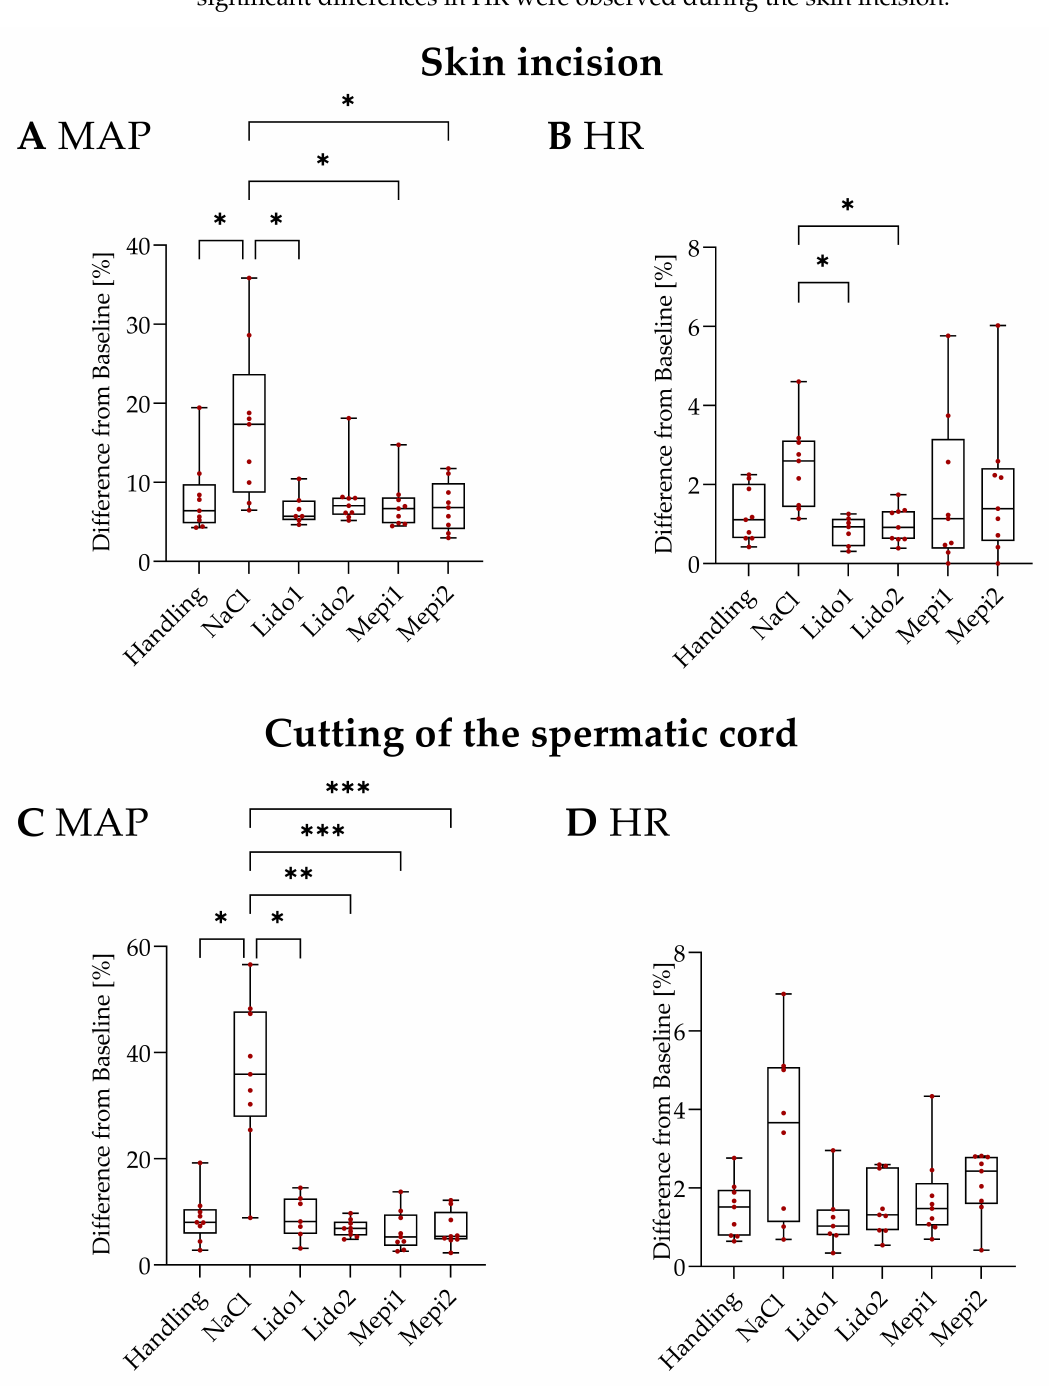
Figure 5. Castration. Percent change in MAP ( A , C ) and HR ( B , D ) during skin incision ( A , B ) and cutting of the spermatic cord ( C , D ). Values shown are means ± SD. Statistical significance is indicated as * p ≤ 0.05, ** p < 0.01, *** p <